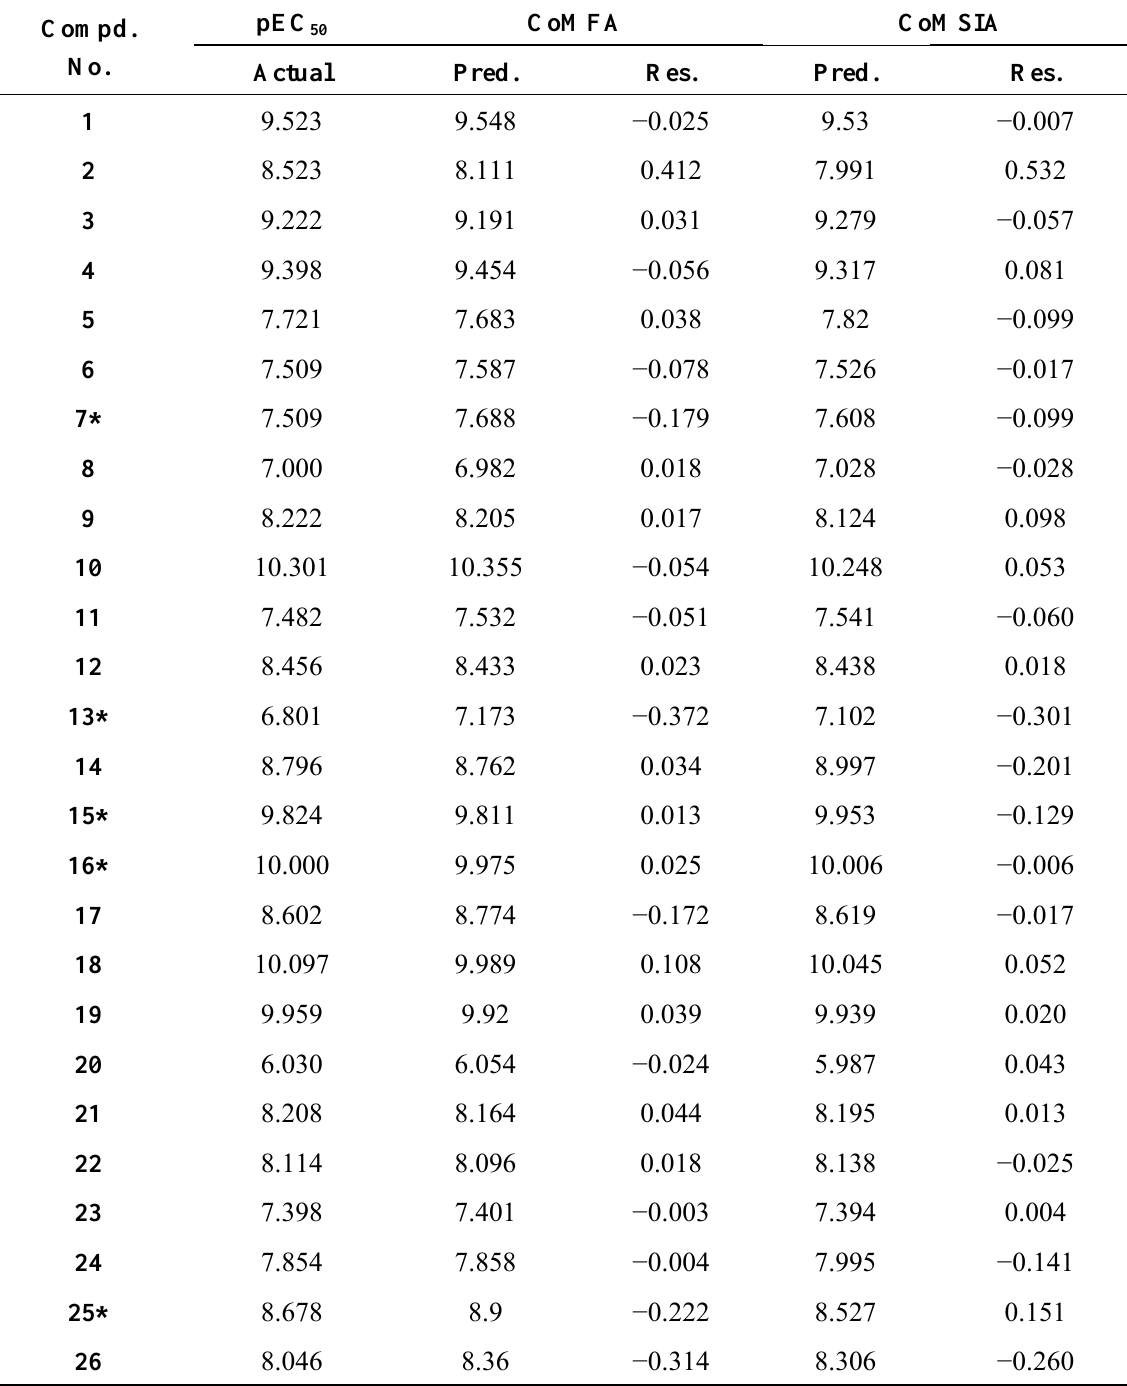
Table 2. The actual pEC training and test set